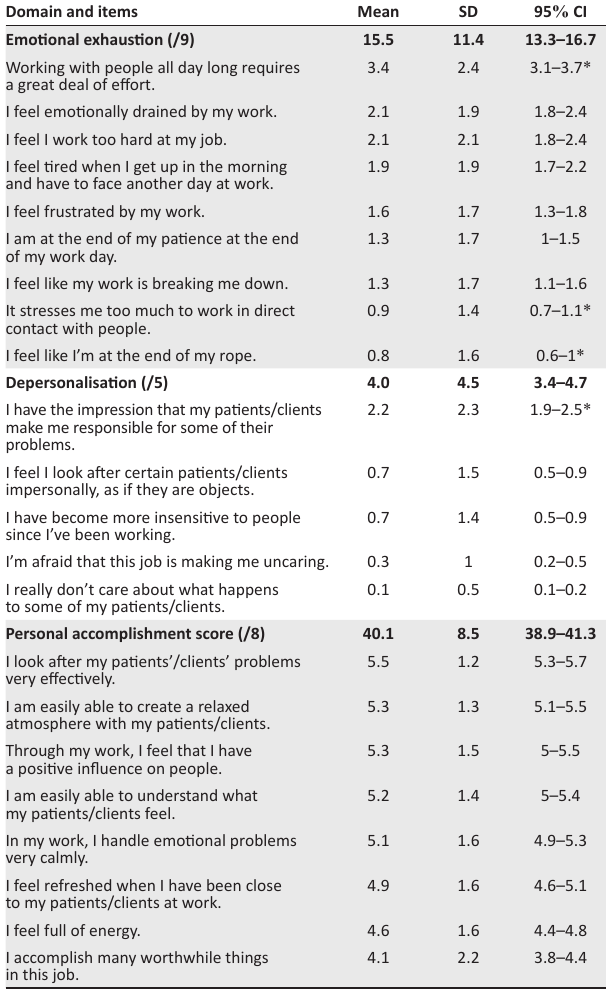
TABLE 2: Burnout domains and individual